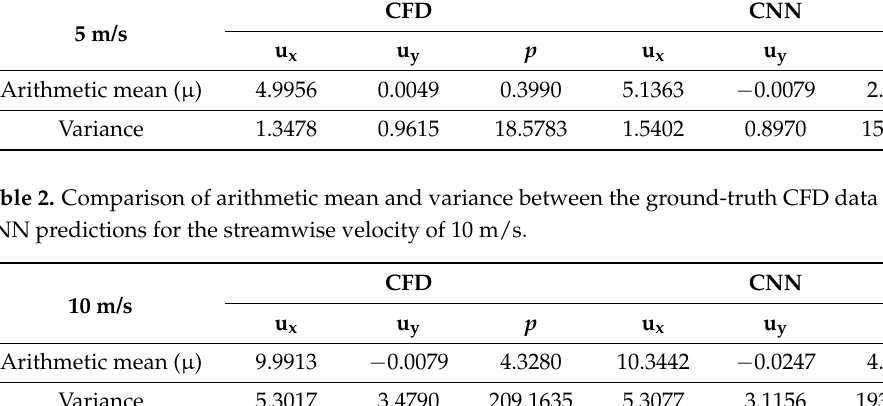
Table 1. Comparison of arithmetic mean and variance between the ground-truth CFD data and the CNN predictions for the streamwise velocity of 5 m/s.